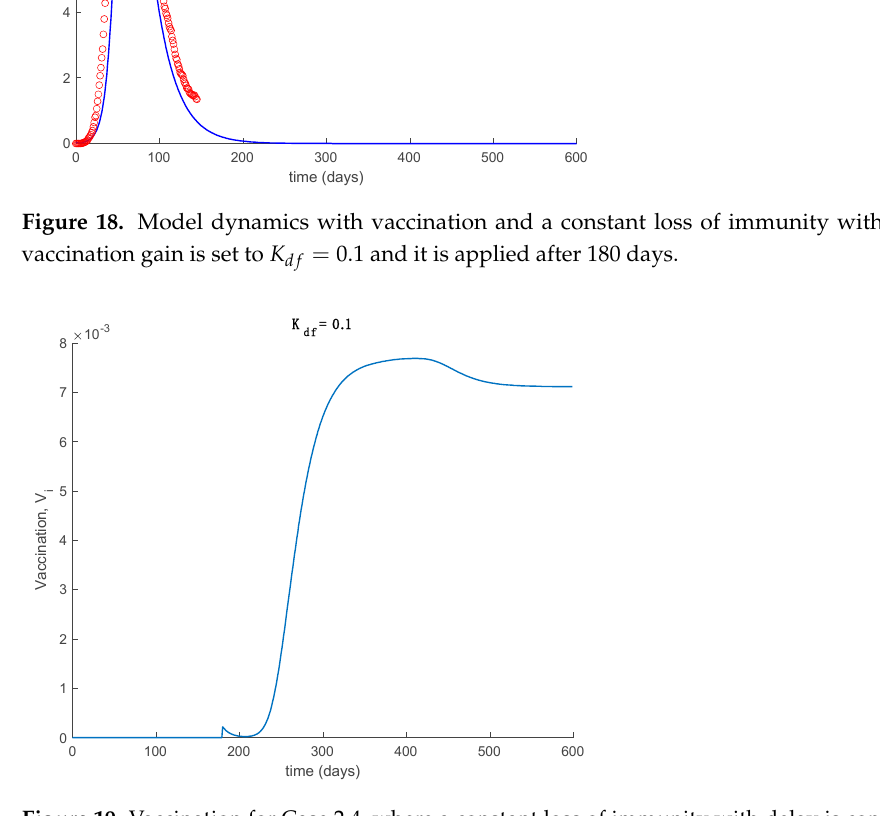
Figure 19. Vaccination for Case 2.4, where a constant loss of immunity with delay is considered. The vaccination gain is set to K df = 0.1 and it is applied after 180 days.